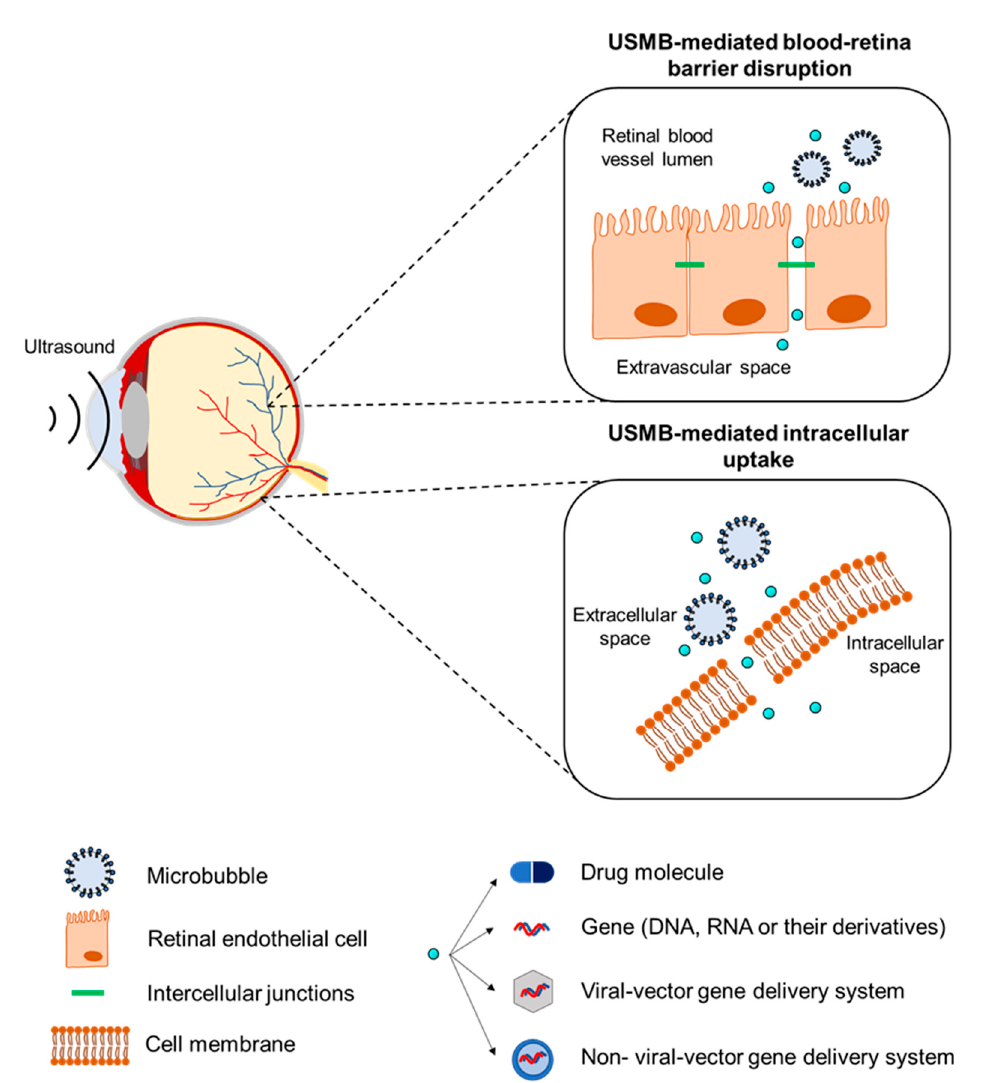
Figure 1. Schematic illustration of the therapeutic applications of